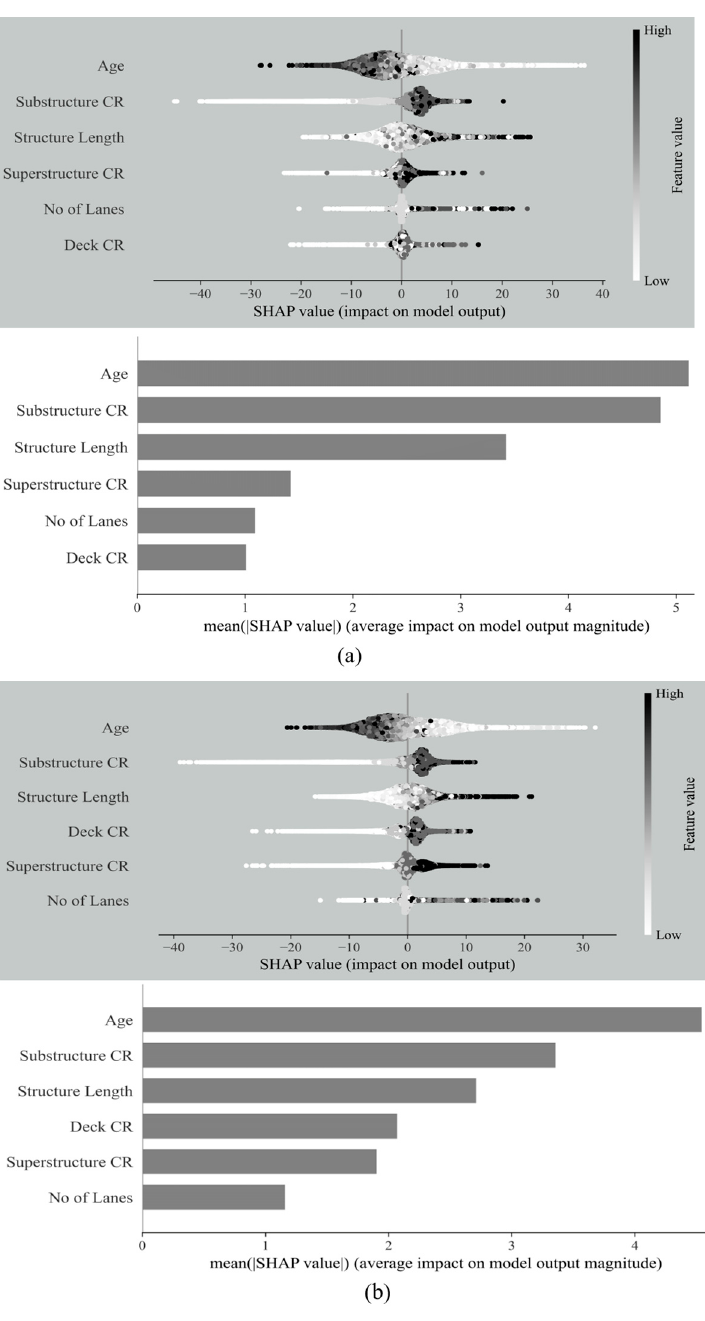
Figure 3. SHAP value plot of attributes from NBI Database using ( a ) XGBoost and ( b ) CatBoost algorithms.